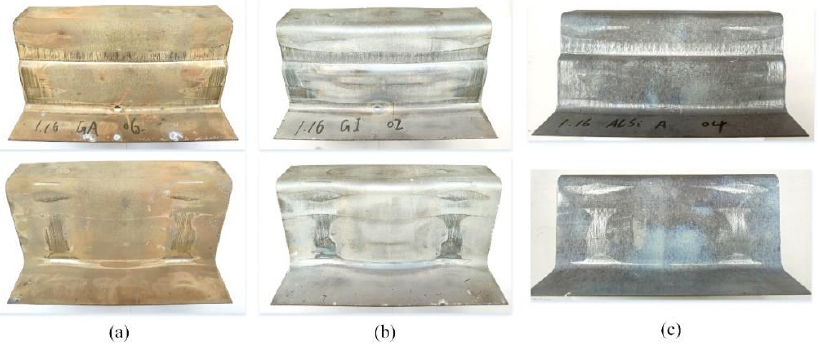
Figure 5. Photographs of hot stamping samples with GA coating, GI coating and Al–Si coating: ( a ) GA coating sample; ( b ) GI coating sample; ( c ) Al–Si coating sample.